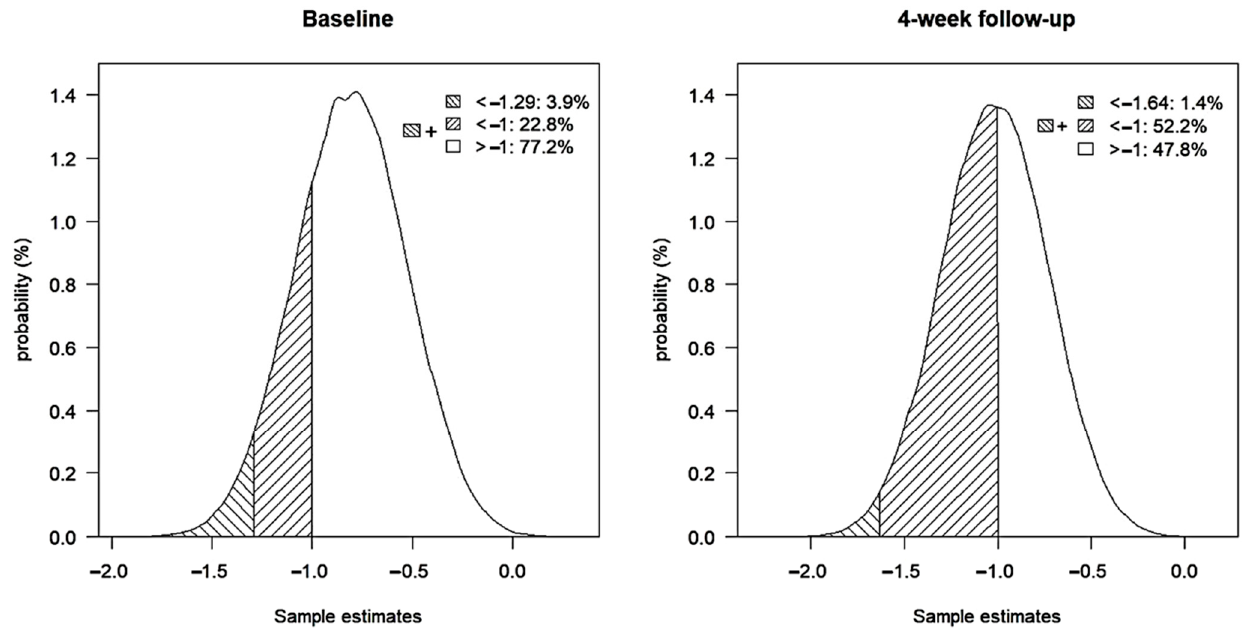
Figure 4. Distribution of sample estimates from sensitivity analysis.